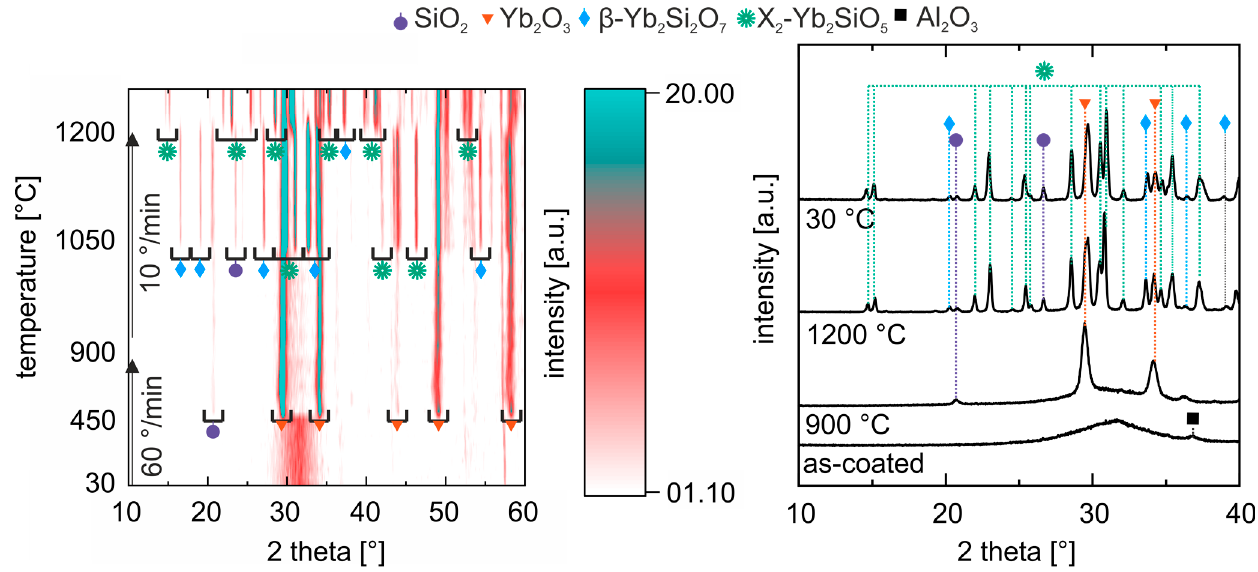
Figure 4. HT-XRD scans of the YbDS and YbMS coating on an Al 2 O 3 substrate; ( a ) contour colour plot of one-minute scans from 10°–60° starting at 30 °C followed by 1 h at 900 °C and 1 h at 1200 °C in air; ( b ) X-ray scans in the as-coated state at 30 °C, during 1 h at 900 °C, during 1 h at 1200 °C and after cooling down in the crystallised state to 30 °C.